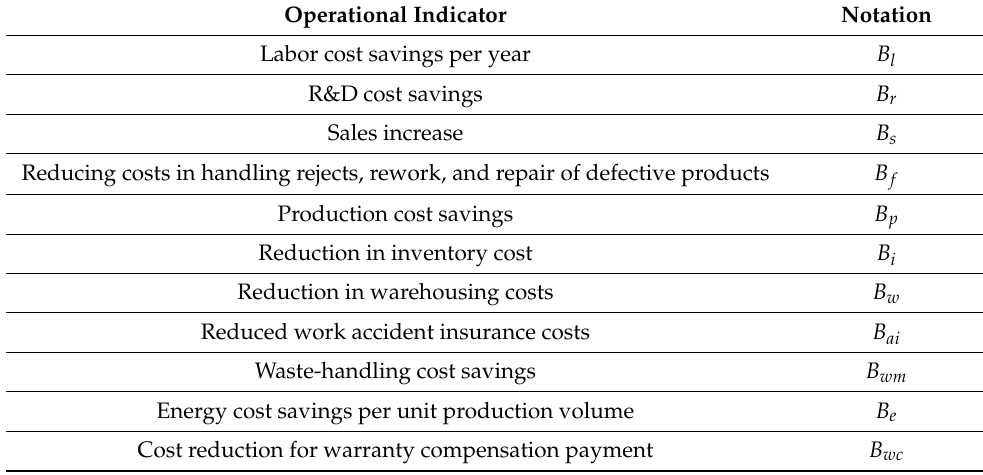
Table 4. Benefit